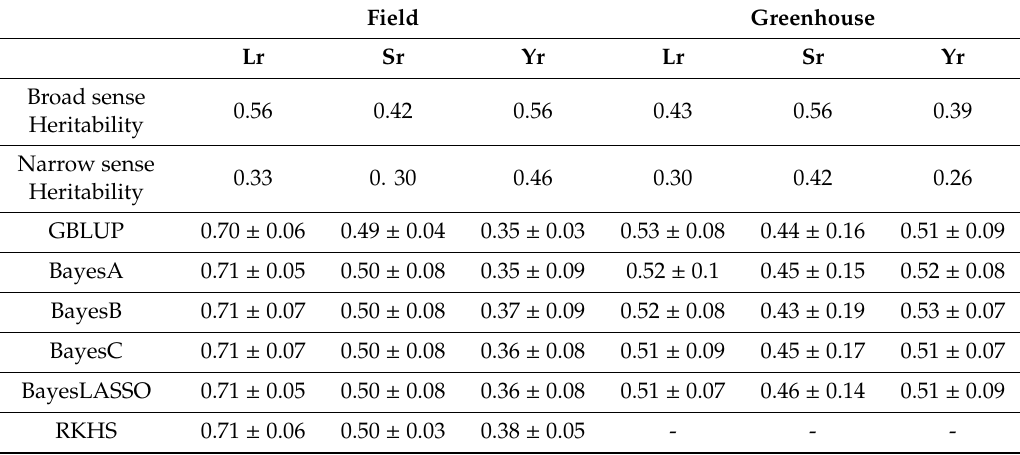
Table 2. Genetic and additive heritability, prediction accuracy ( ± ) standard errors for adult plant (Field) and seedling resistance (Greenhouse) using di ff erent prediction models for rust traits.